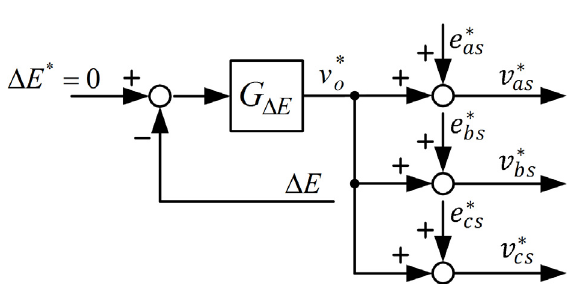
Figure 7. Control block diagram of the three-phase, three-level